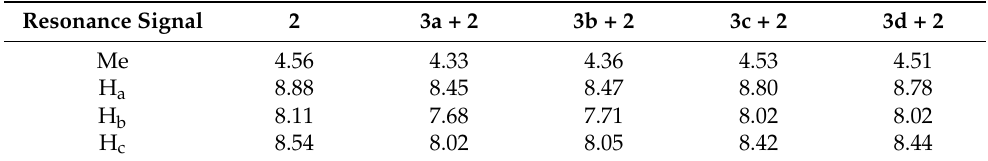
Figure 6. 1 H NMR (400 MHz) host–guest complexation studies in CD 2 Cl 2 (5 mM). Table 2. Comparative studies of the 1 H NMR chemical shifts ( δ , ppm) of 2 within the calixarene cavities (CD 2 Cl 2 , 5